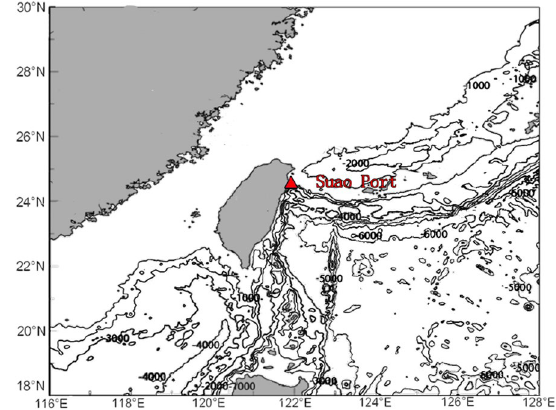
Fig. 4 Location of the verification point